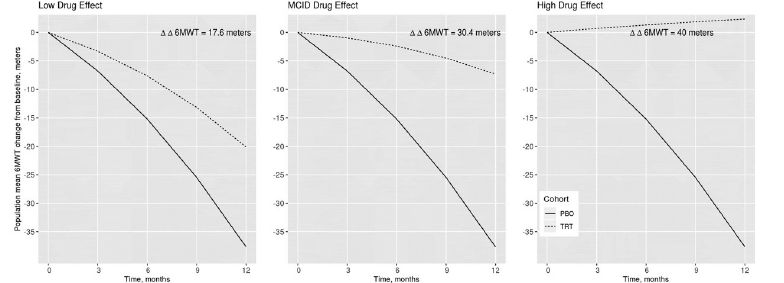
Fig 4. Population mean simulations of the natural history and hypothetical drug effect model at three drug effect levels (low, minimal clinically important difference (MCID), and high). The drug effect model was calibrated to achieve the three desired placebo-corrected change from baseline 6MWT ( ΔΔ 6MWT) values at 12 months post- baseline.